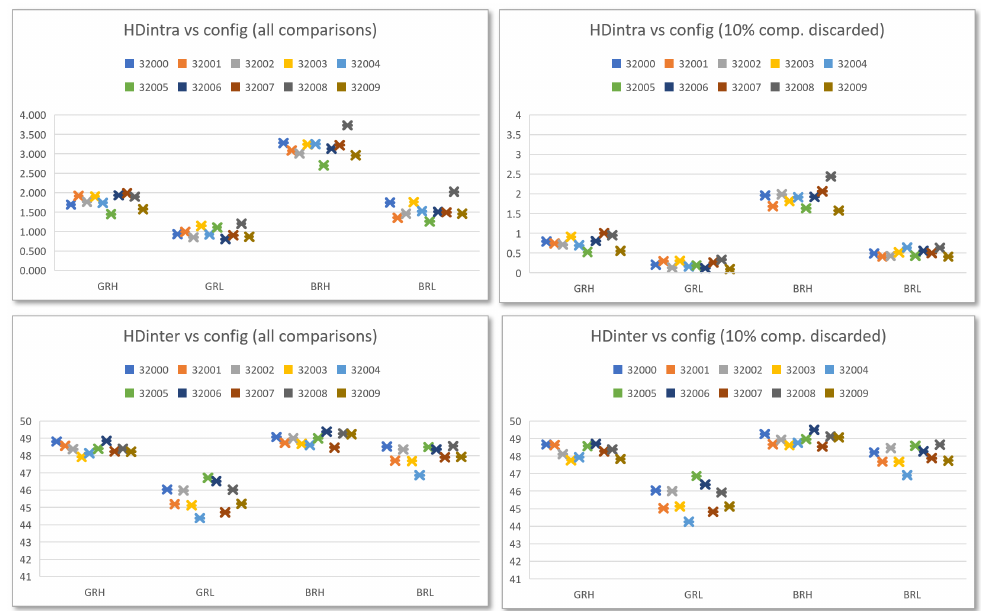
Figure 13. HDintra ( top ) and HDinter ( bottom ) values before ( left ) and after ( right ) discarding 10% of challenges for different